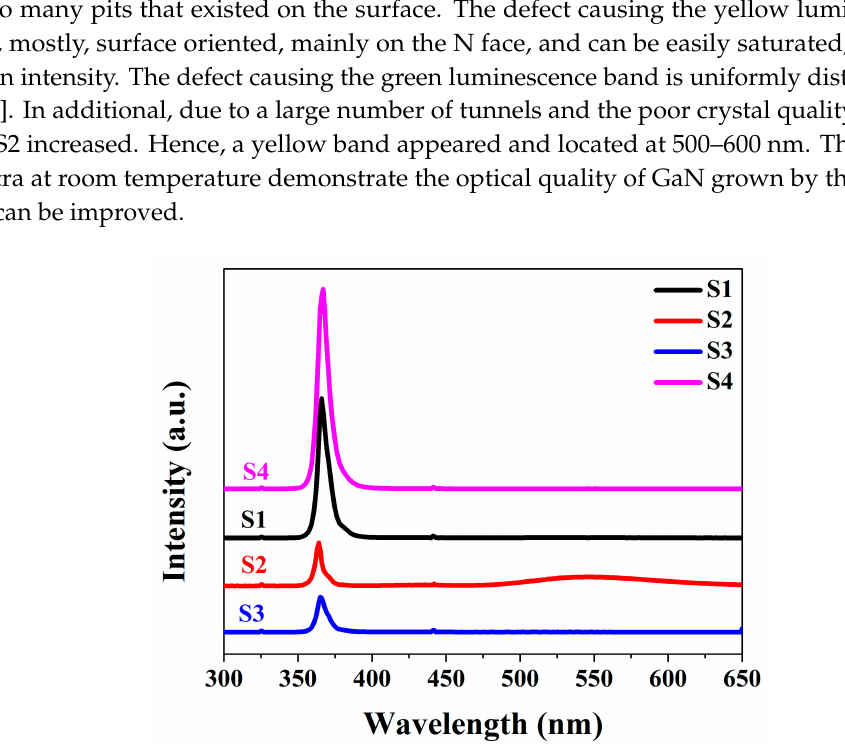
Figure 6. PL spectra of di ff erent GaN samples grown by